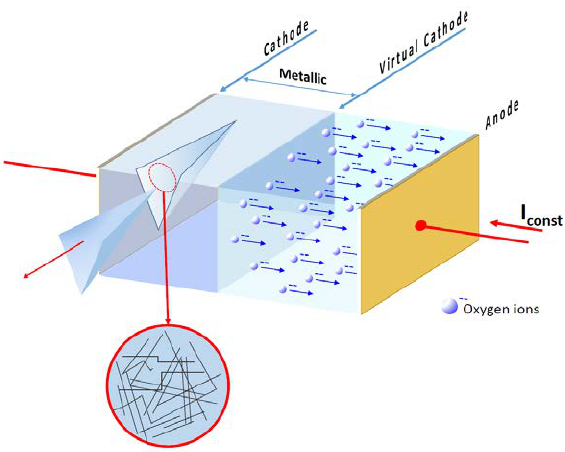
Figure 48. Schematic illustration of the electroreduction process. Adapted from [59].